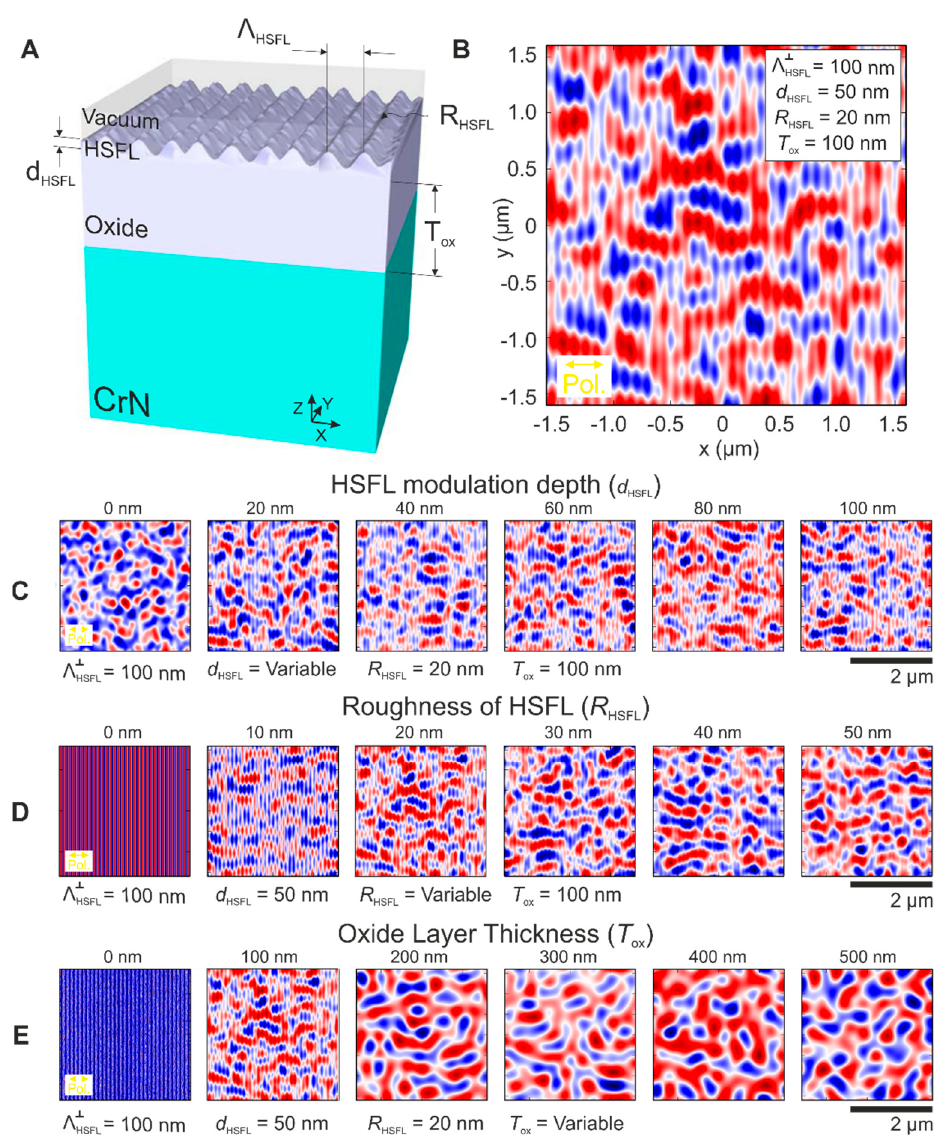
Figure 8. ( A ) 3D-representation (not to scale) of the simulated domain with dimensions in X and Y of 3.2 µm and variable Z including the different layers, visualizing the relevant parameters studied in the finite-difference time-domain (FDTD) simulations. ( B ) Intensity pattern obtained at the interface of the oxide layer and the CrN sample for a sample with HSFL periodicity Λ HSFL ⊥ = 100 nm, HSFL modulation depth d HSFL = 50 nm, roughness of the HSFL R HSFL = 20 nm, and oxide layer thickness T ox = 100 nm. Subsequent simulations take into account the same conditions as in ( B ) changing in ( C ) d HSFL , from 0 to 100 nm, ( D ) R HSFL from 0 to 50 nm and in ( E ) T ox from 0 to 500 nm. The laser beam ( λ = 800 nm) polarization direction is horizontal. The colors of the intensity plots are encoded in a false color scheme where red indicated deviations above and blue below the average intensity value of the image, represented in white.